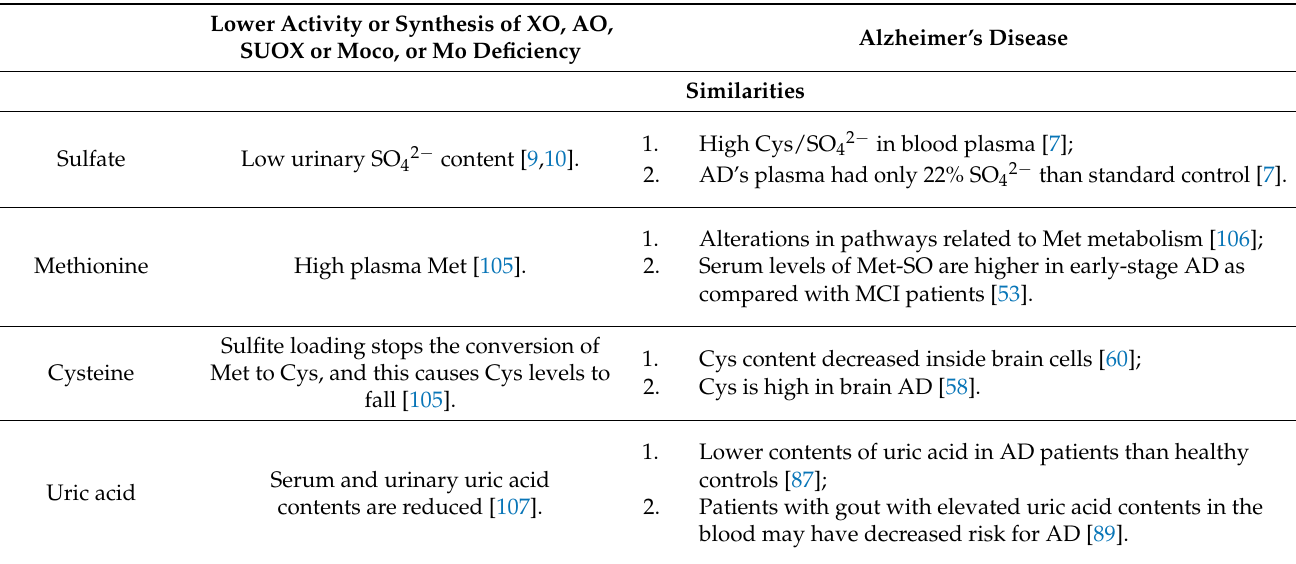
Table 1. Similarities among lower activity or synthesis of XO, AO, SUOX, and Moco or Mo deficiency and symptoms of Alzheimer’s